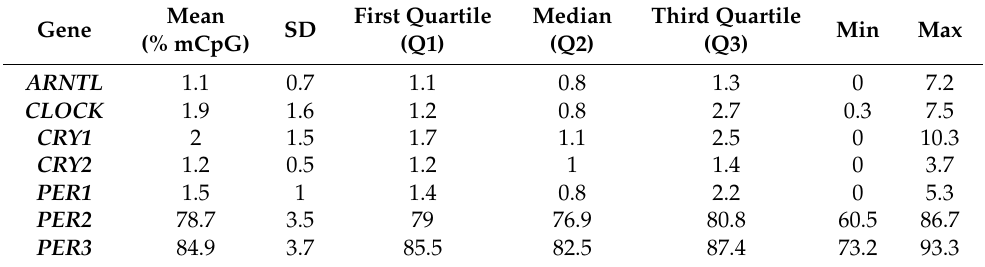
Table 4. Methylation values of clock genes.